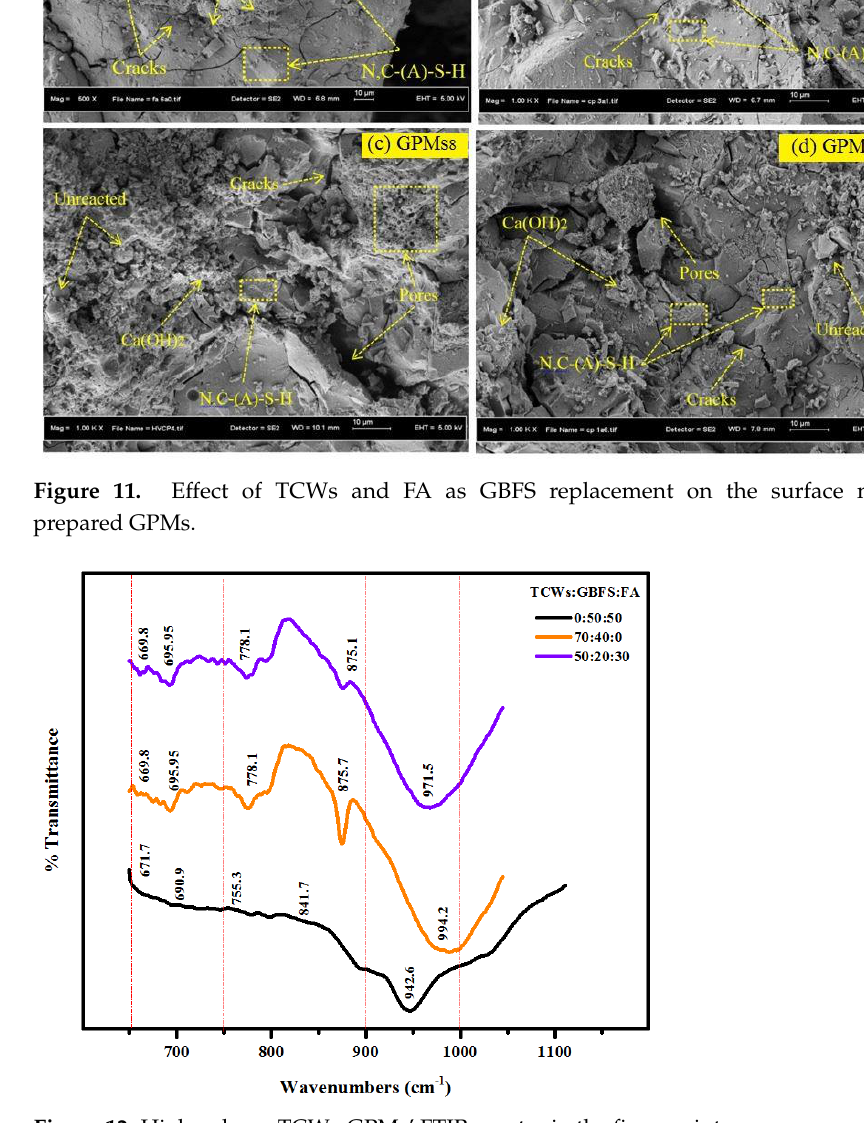
Figure 12. High volume TCWs-GPMs’ FTIR spectra in the fingerprint